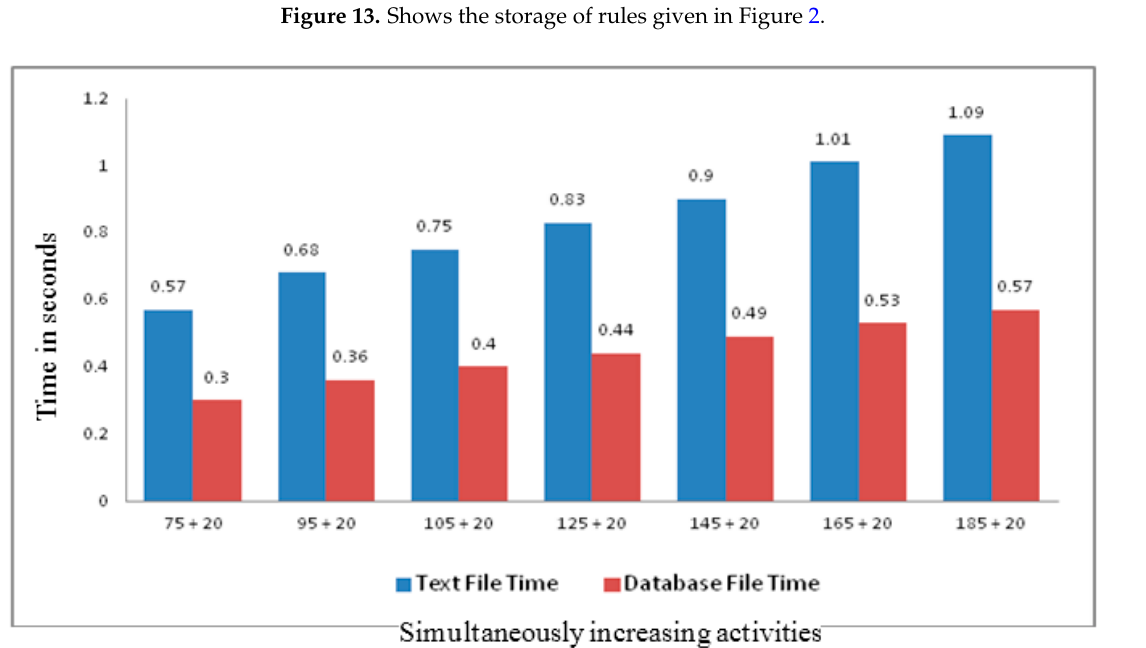
Figure 14. The performance comparison of proposed Self Evolutionary Rule-base against Text based rules storage.